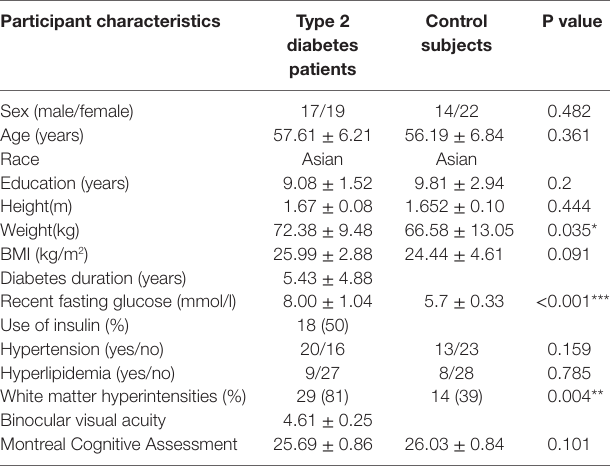
TaBle 1 | Patient